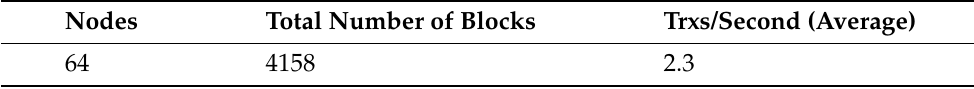
Table 5. FlexiChain Technology Number of